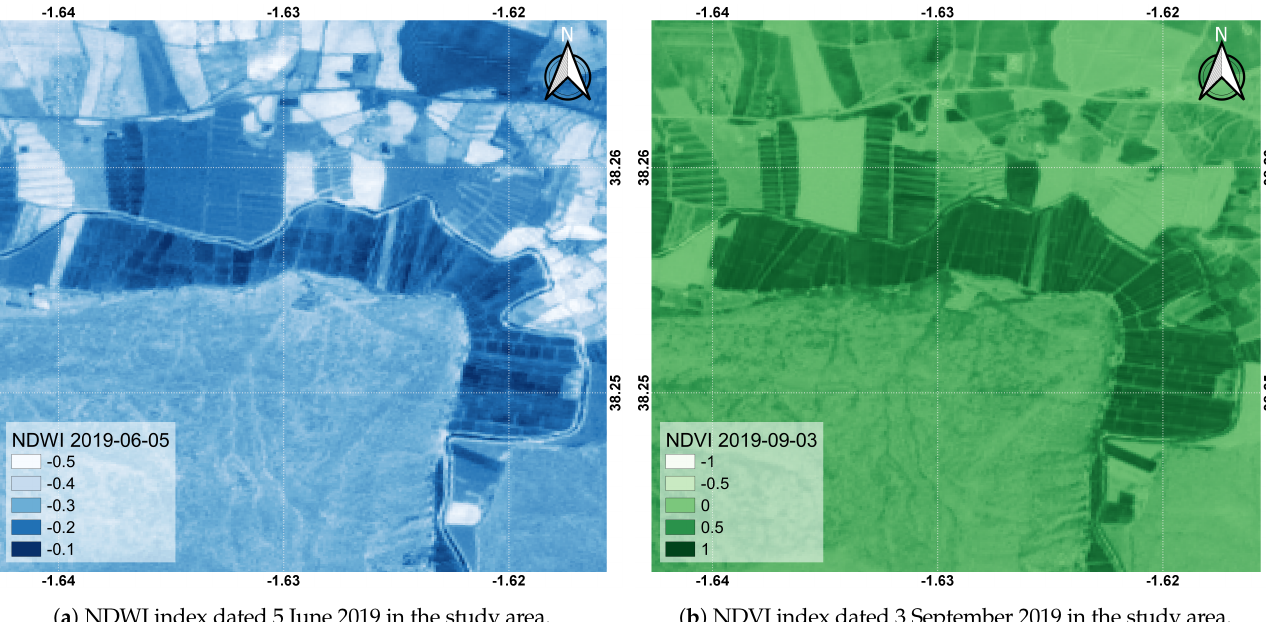
Figure 5. NDVI and NDWI indices of S2 for the study